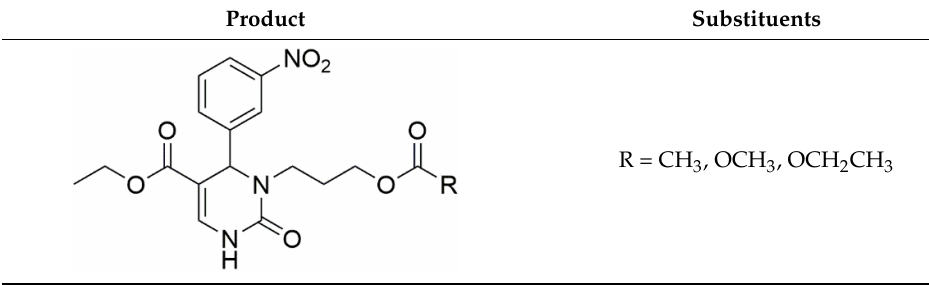
Table 1. Synthesis of several CCBs created by lipophilic alkyl and aryl